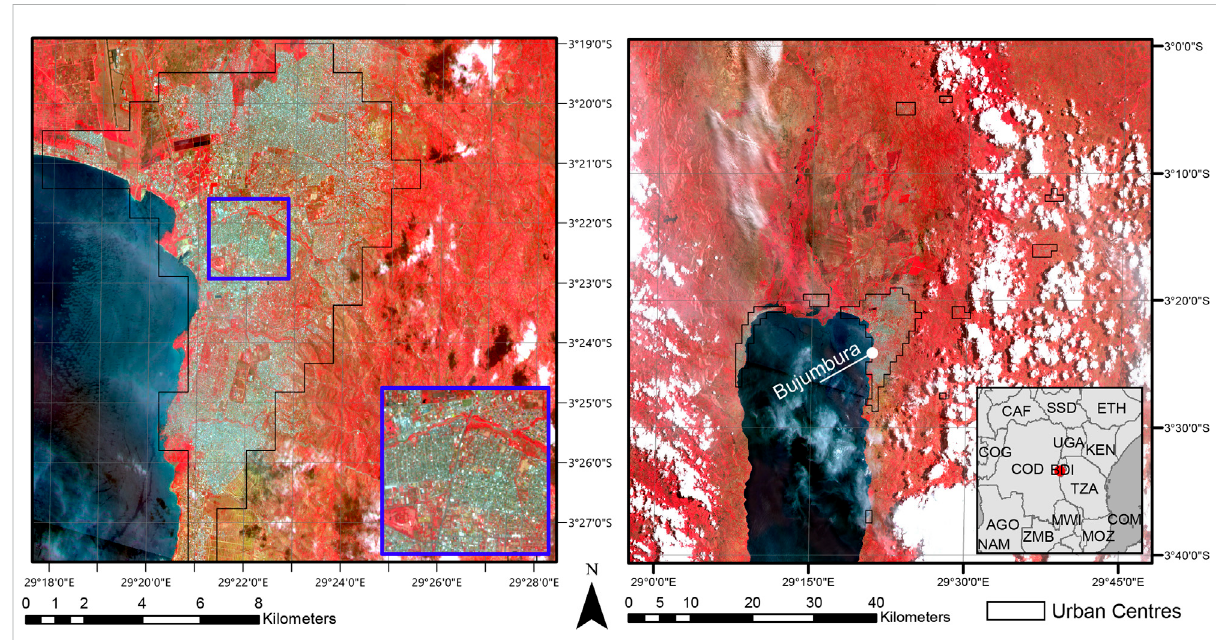
FIGURE 3 Example of urban centre delineation (delineation with the 1 km grid in black) and magni fi cation of the morphological structure (extract in blue, showing an area of 3 × 3 km) derived from Copernicus Sentinel-2 10 m optical satellite imagery in the area of the Bujumbura (Burundi). Copernicus Sentinel data acquired in 2022 and displayed in false color composite using near infrared, red and green bands. Retrieved from SentinelHub in July 2022, processed by